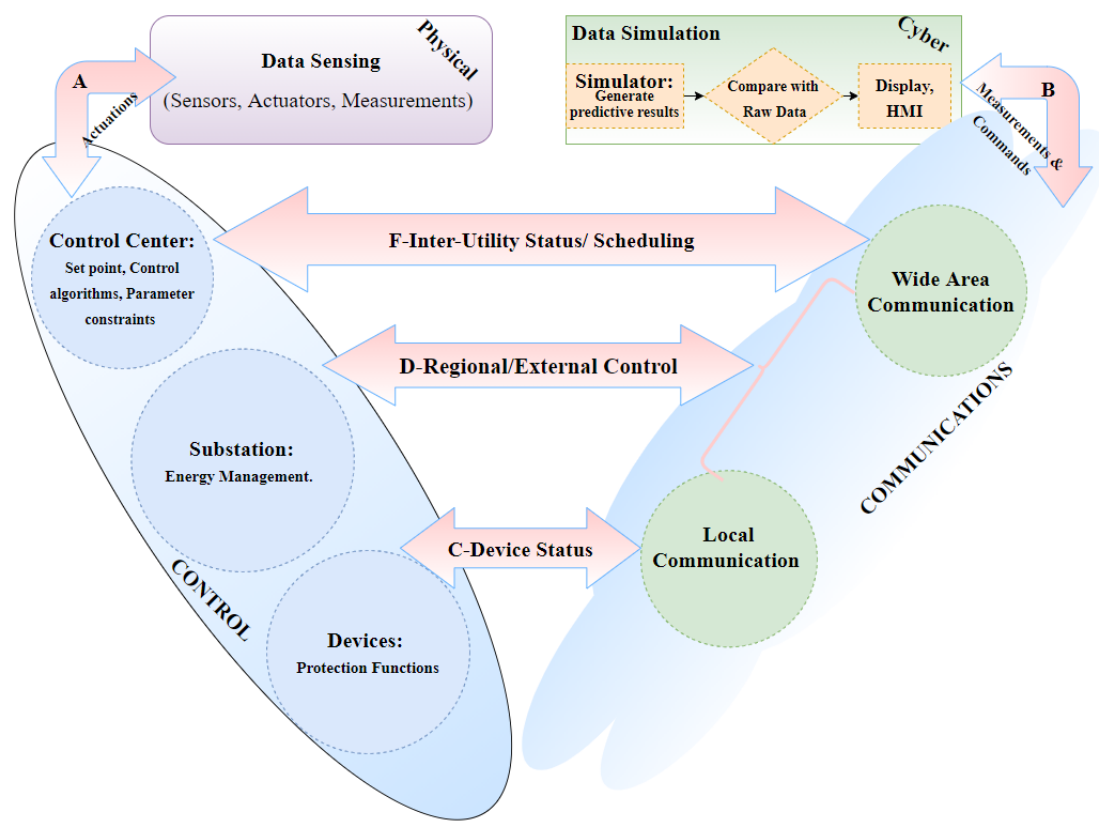
Figure 4. Logical Architecture of CP-SG